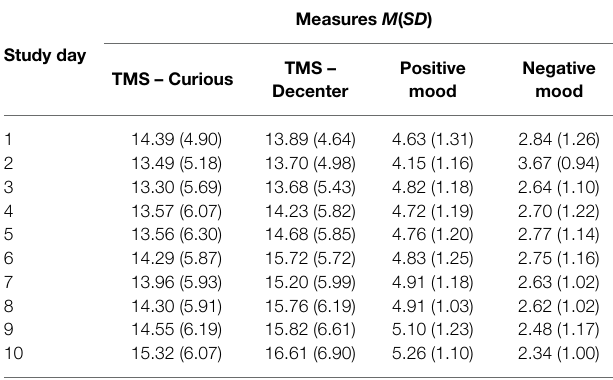
TABLE 3 | Descriptive statistics for state mindfulness and mood across study